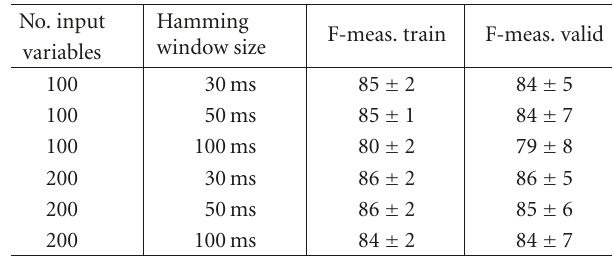
Table 4: Results from tests combining STFT log-magnitude plane with the phase di ff erence across frequency plane as input to the network. Unfortunately, the addition of phase di ff erence in the fre- quency axis does not yield better results than the STFT log magni- tude alone.